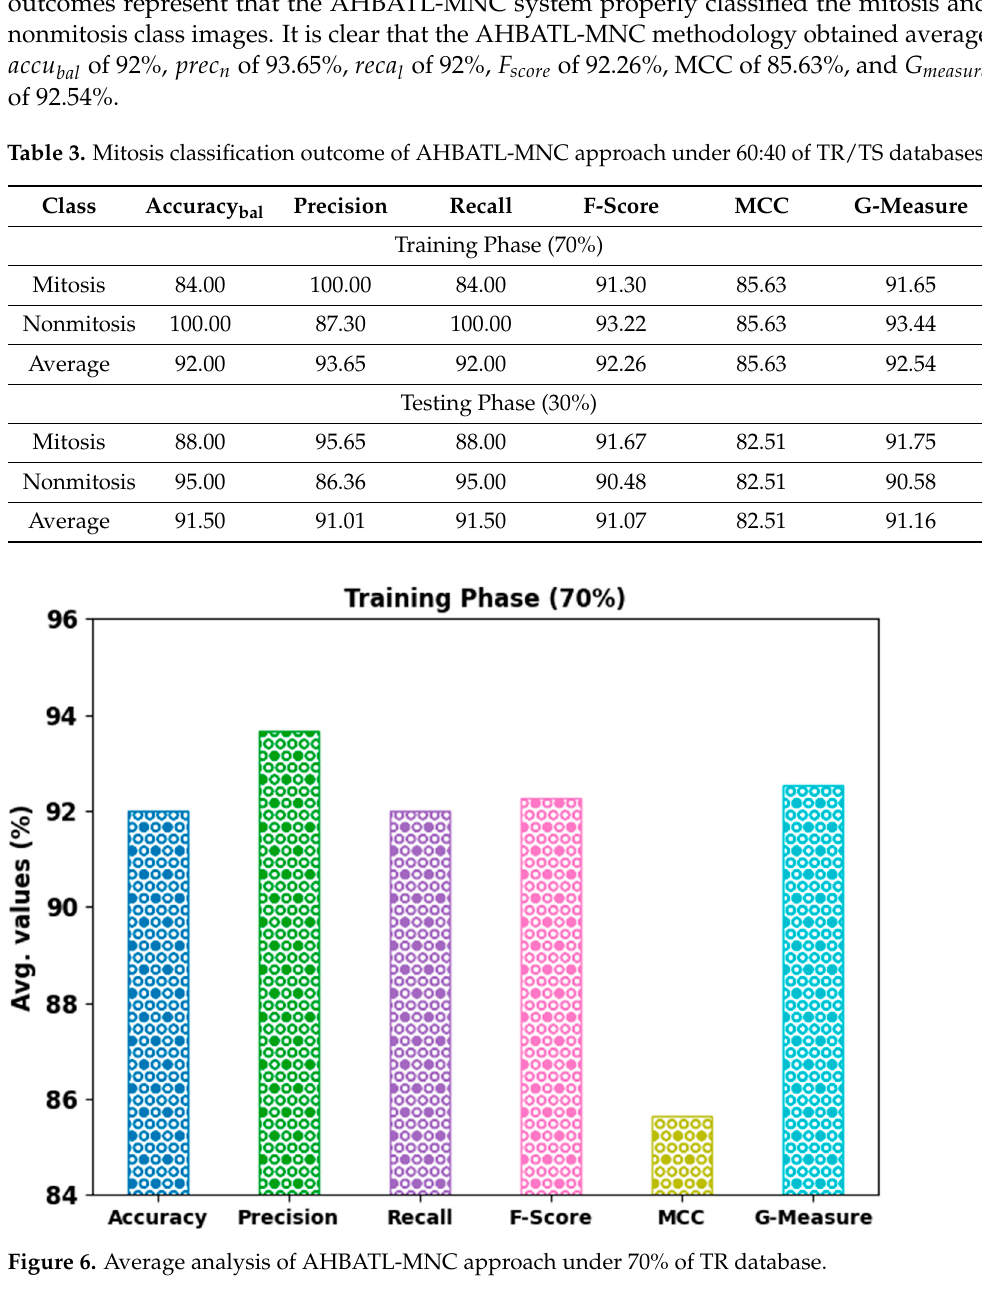
Figure 7. Average analysis of AHBATL-MNC approach under 30% of TS database.